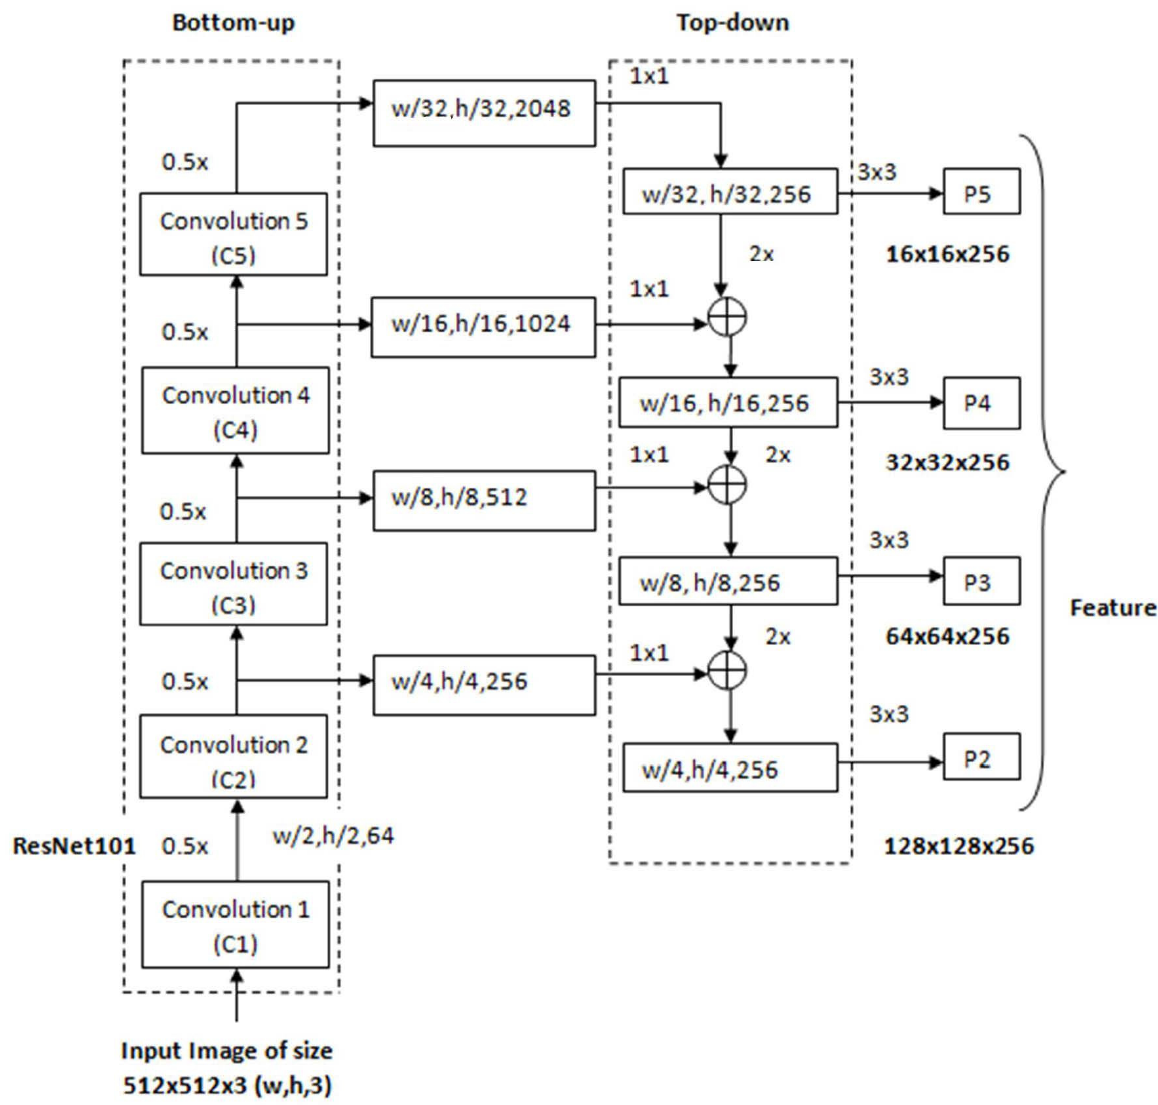
Figure 4. ResNet101-based Feature Pyramid Network Architecture. Table 1. Differences between ResNet50 and ResNet101 layers.